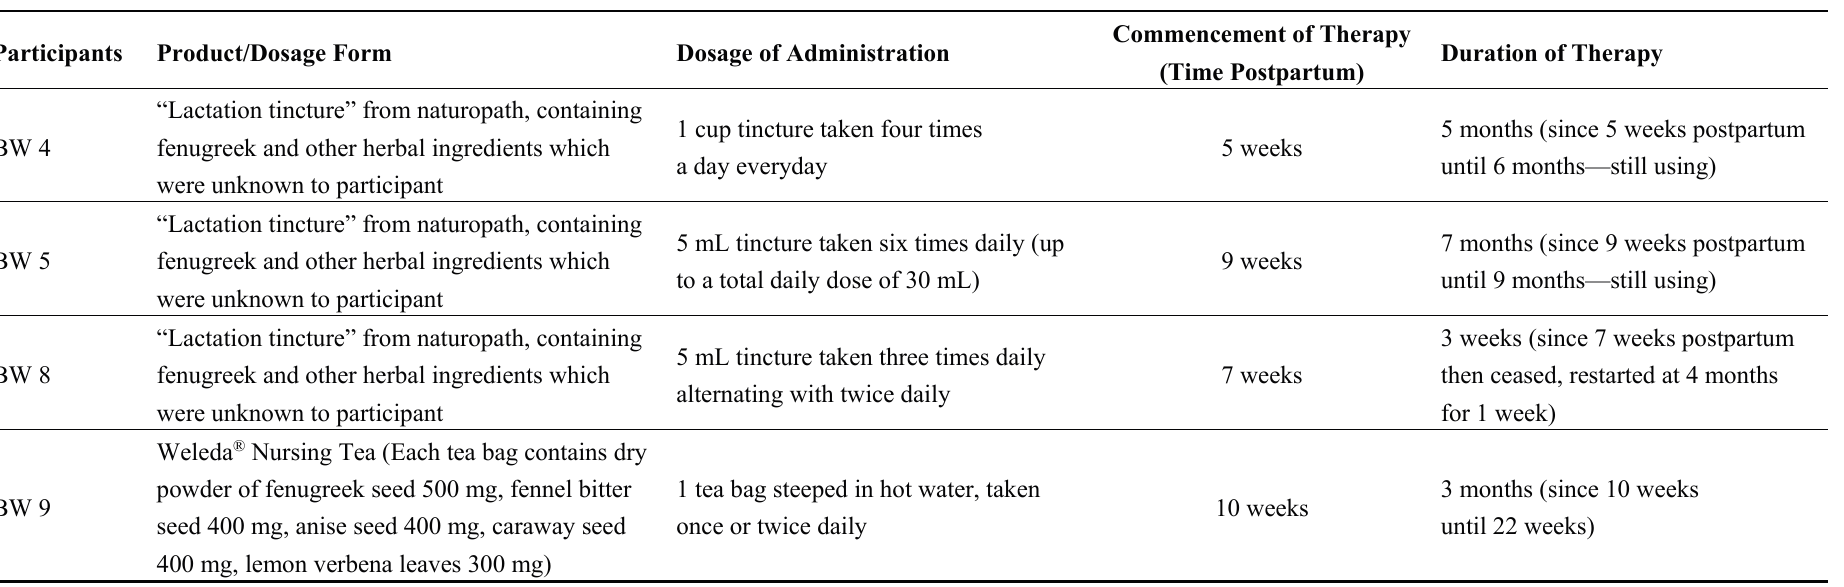
Table 3. Summary of the pattern of use: naturopaths’ own “lactation tincture” with a combination of herbal